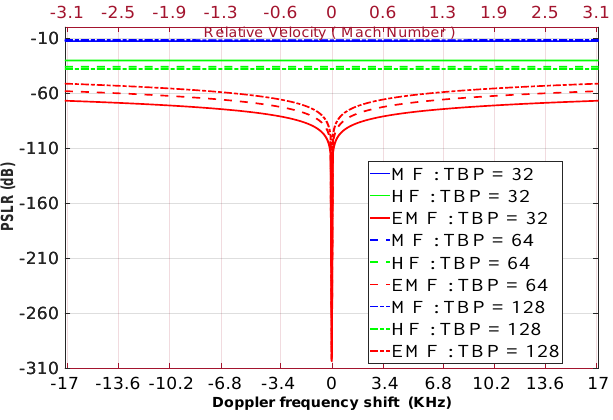
Figure 14. PSLR versus Doppler frequency for the LFM MF, HF, and proposed EMF.